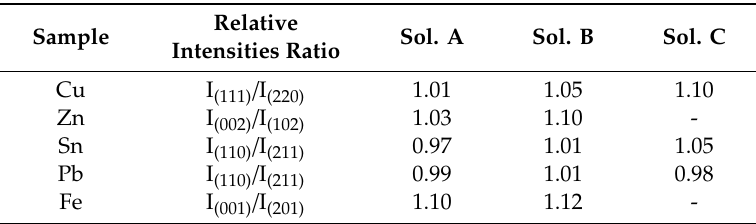
Table 7. Preferential orientation tendency of the crystallites of the corrosion products in di ff erent bromide-based electrolytes.